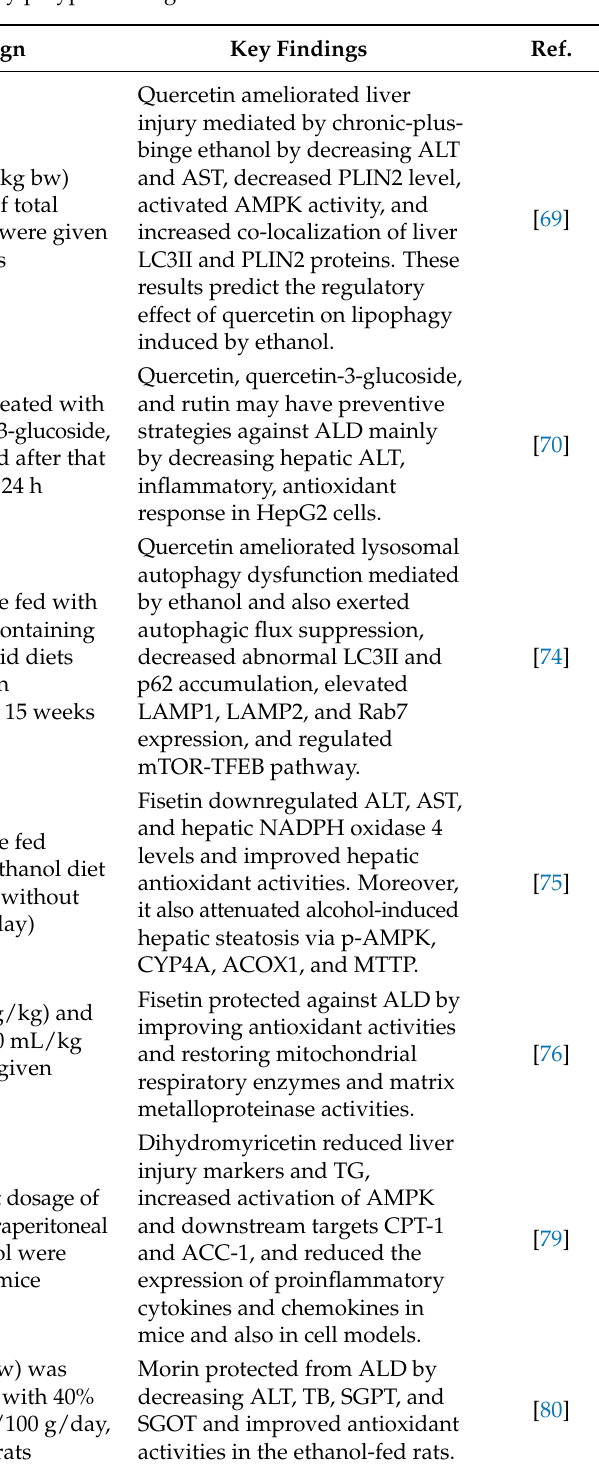
Table 1. Protective effects of dietary polyphenols against